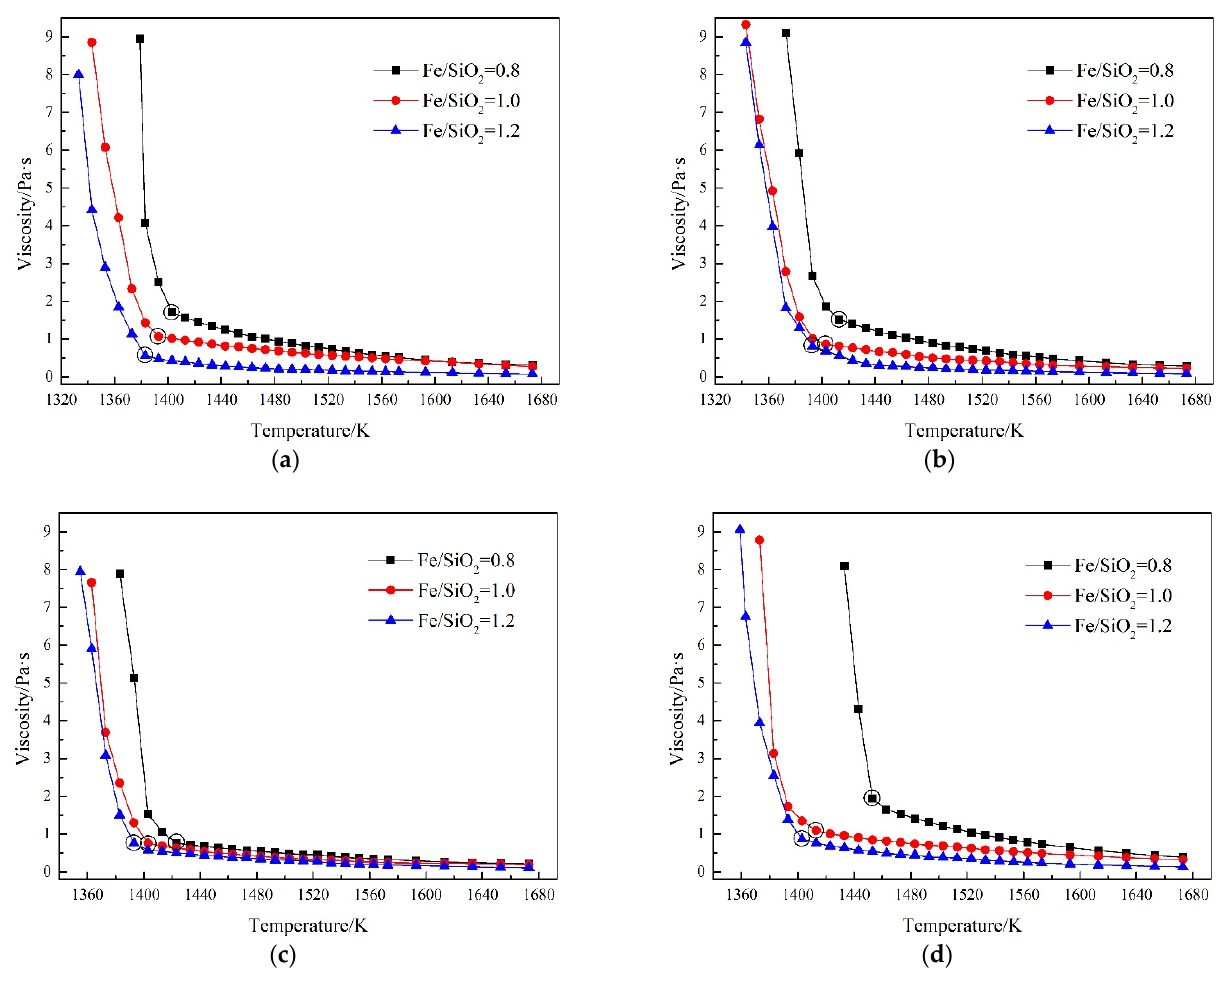
Figure 3. Viscosity changes versus temperature for varying Fe/SiO 2 ratios of the FeO − Fe 2 O 3 − SiO 2 − 8 wt%CaO − 3